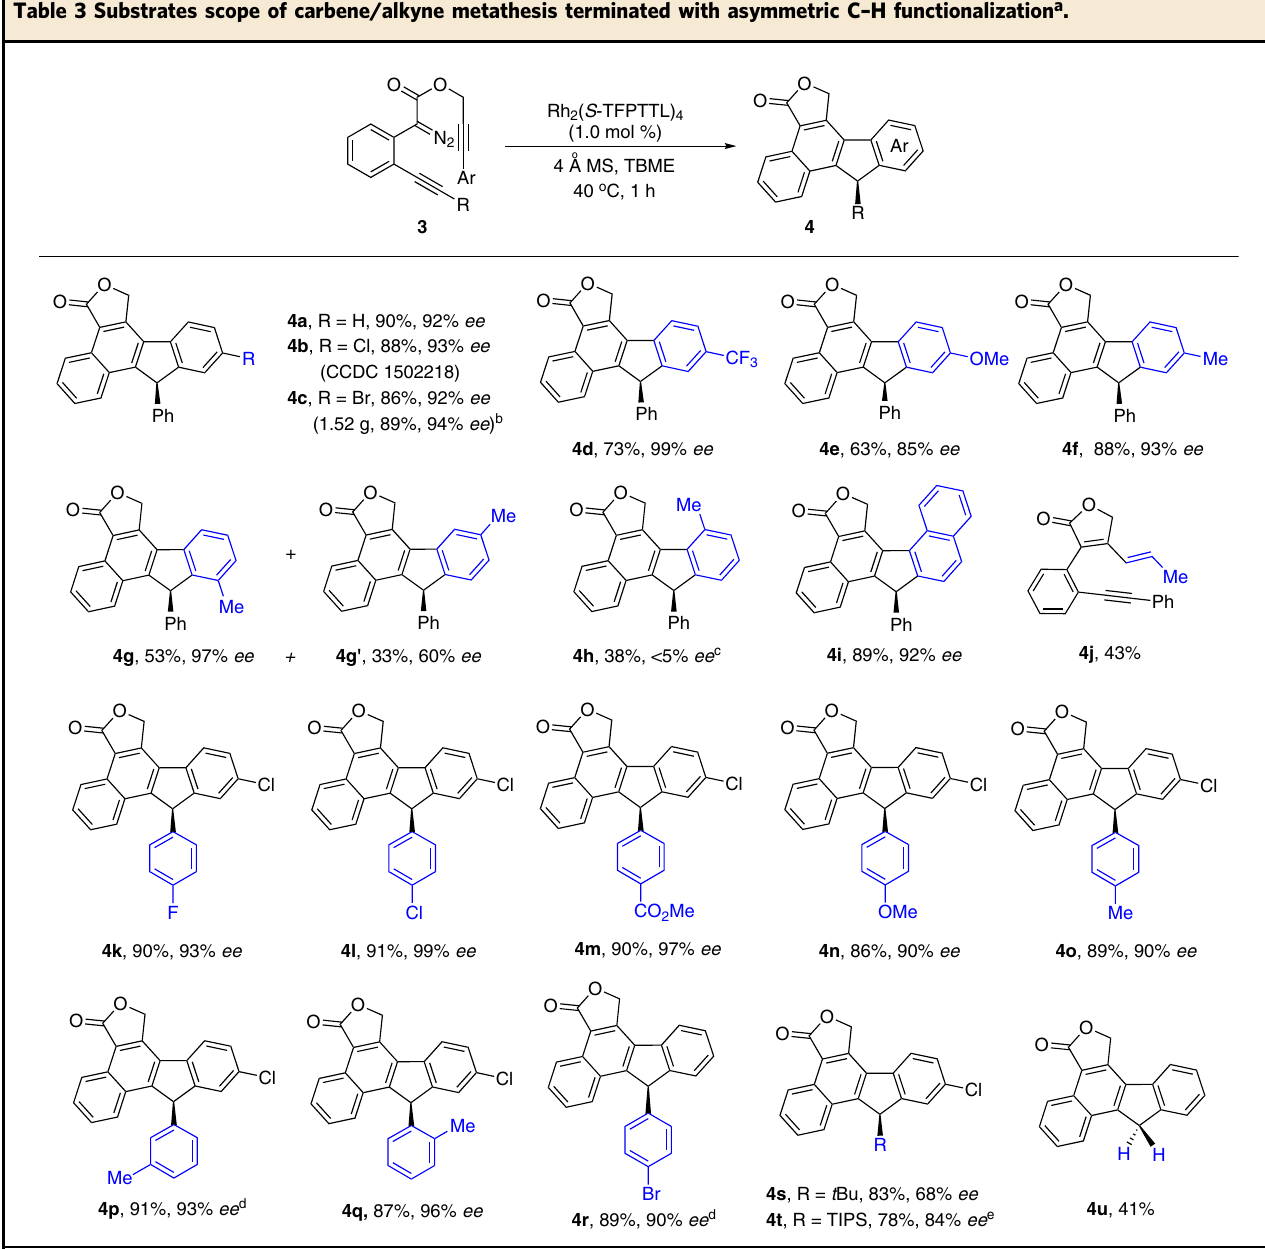
Table 3 Substrates scope of carbene/alkyne metathesis terminated with asymmetric C – H functionalization a